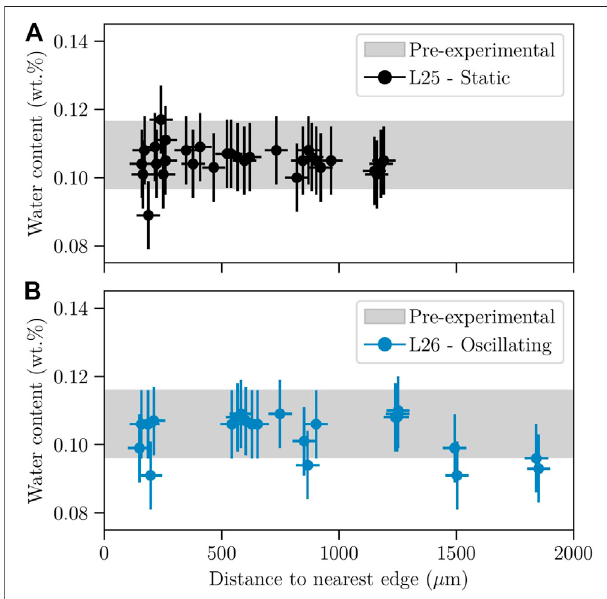
FIGURE7| Post-experimentalwatercontents(fromFTIRspectroscopy) as a function of the distance to the nearest edge or bubble for the two 1-h experiments presented in Figures 4 and 6 , L25 (static) and L26 (oscillating). The range ofwater contents in theoriginalsamplesare indicated asgrey bands for